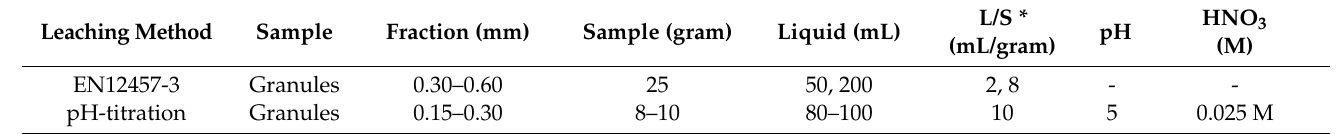
Table 1. Experimental conditions for leaching tests.